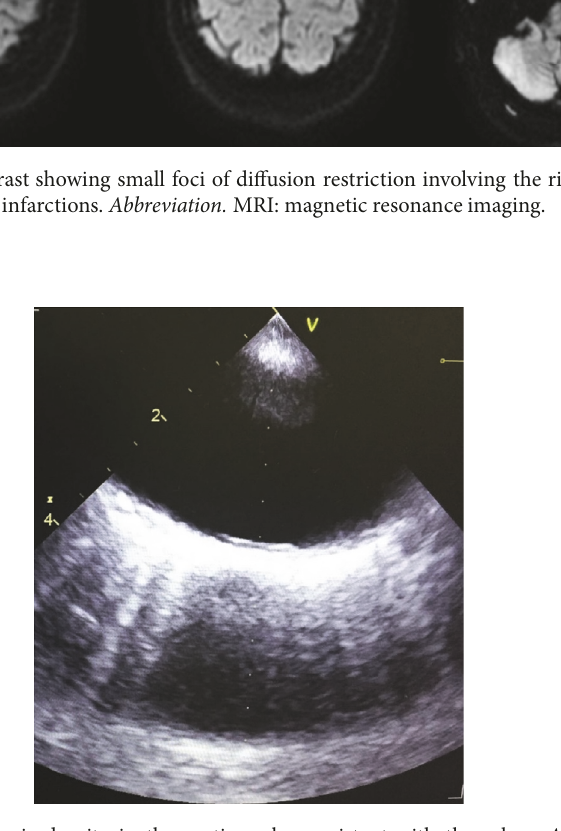
Figure 2: TEE demonstrating an echogenic density in the aortic arch, consistent with thrombus. Abbreviation. TEE: transesophageal echocardiogram.